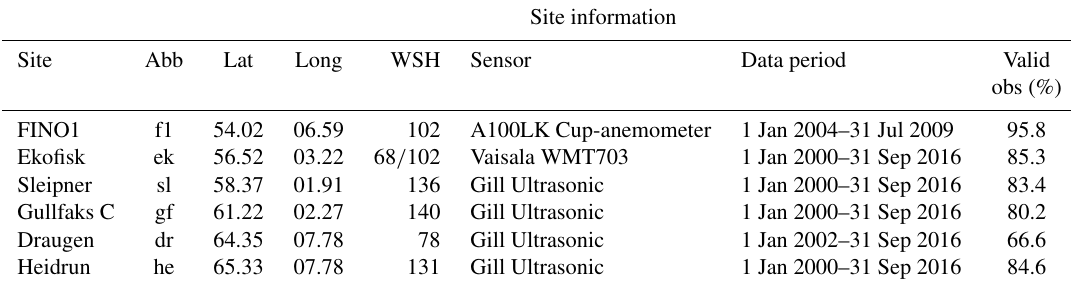
Table 1. Relevant information for the sites used in the validation of NORA3. “Abb” lists the site-name abbreviations. “Lat” and “Long” are the latitude and longitude for the site locations, respectively. “WSH” (in meters above sea level) corresponds to the wind sensor height at each site. The sensor type is listed under “Sensor”, and the data period for the available observations for each site is listed under “Data period”. In addition, the percentage of valid observations is also shown under “Valid obs